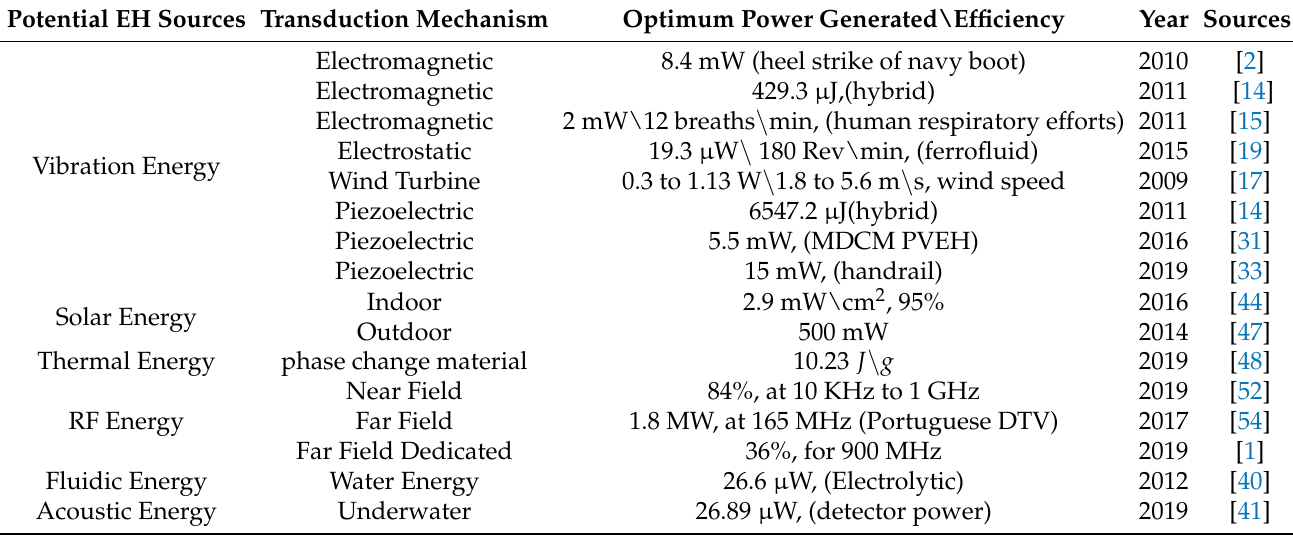
Table 1. SOA of Recent Energy Harvesting Mechanisms in a smart